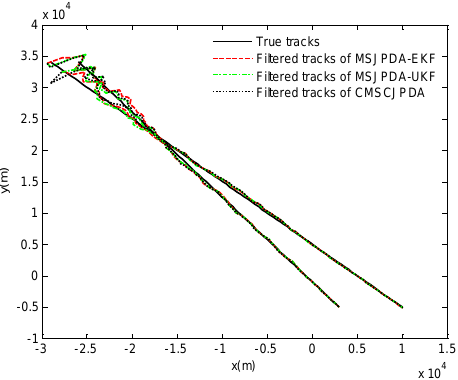
Figure 1. True tracks and filtered tracks of two crossing targets.